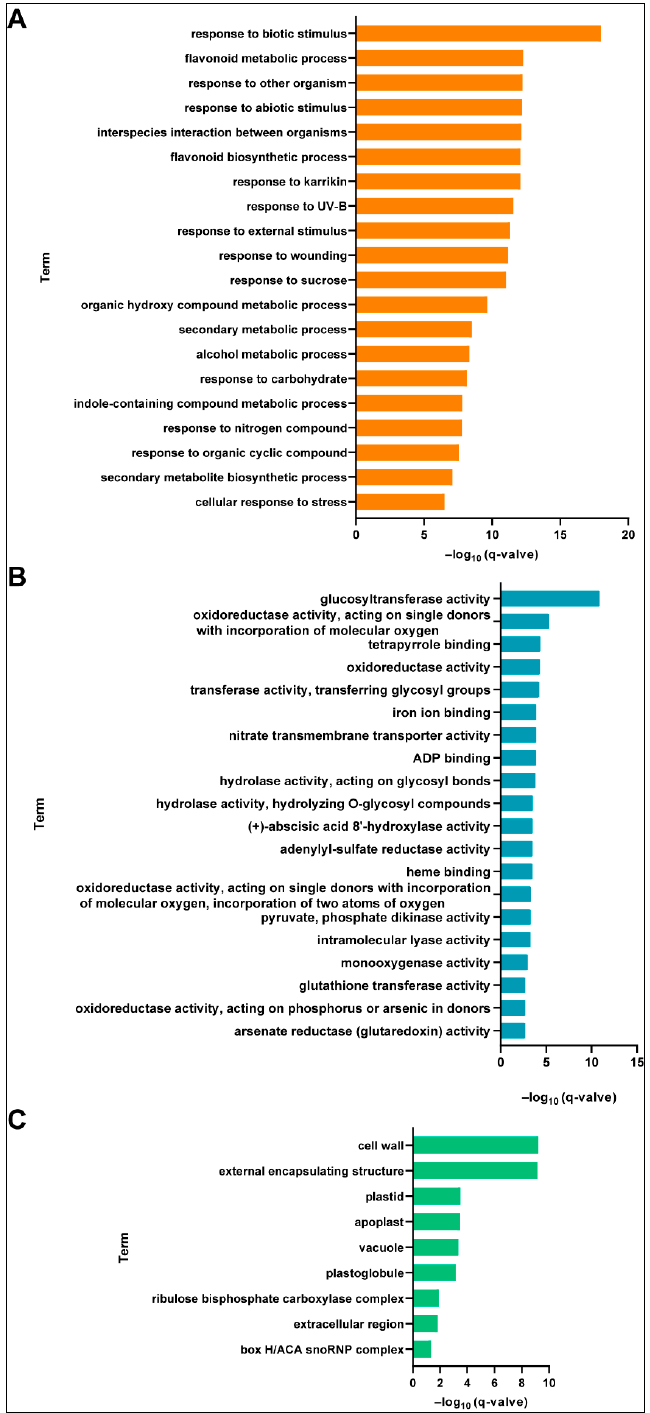
Figure 3. Significantly enriched Gene Ontology (GO) terms in enrichment analysis of 11,888 differ- entially expressed genes (DEGs). Top 20 terms with significant enrichment in biological process ( A ) and molecular function ( B ) in GO category. ( C ) Significantly enriched cellular component terms. GO enrichment analysis was performed using TBtools V1.076; q -value is corrected p -value using Benjamini–Hochberg’s